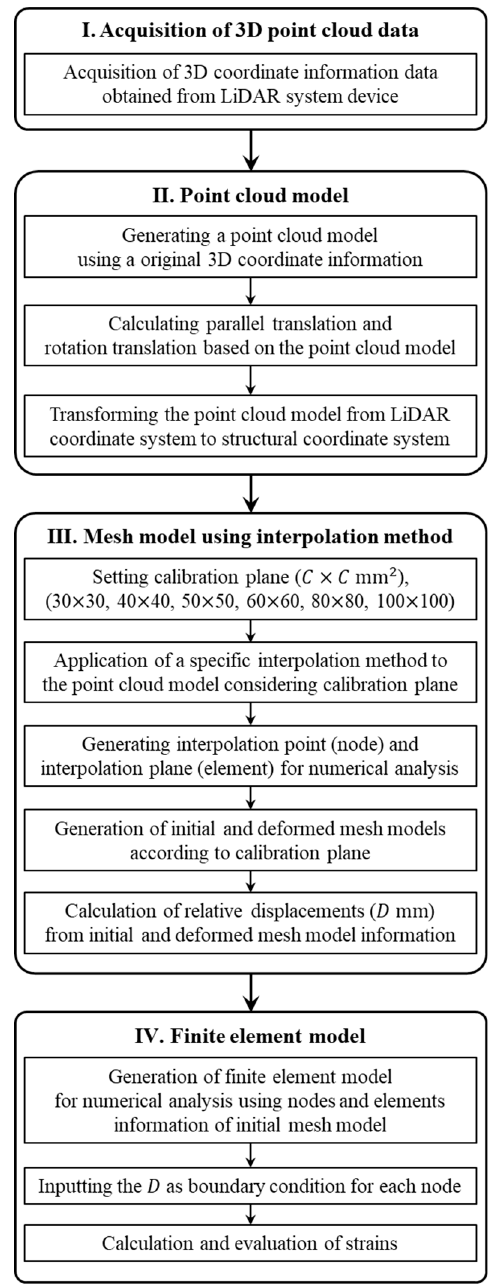
Figure 6. Flowchart for the LiDAR ‐ based strain evaluation method used in this study.